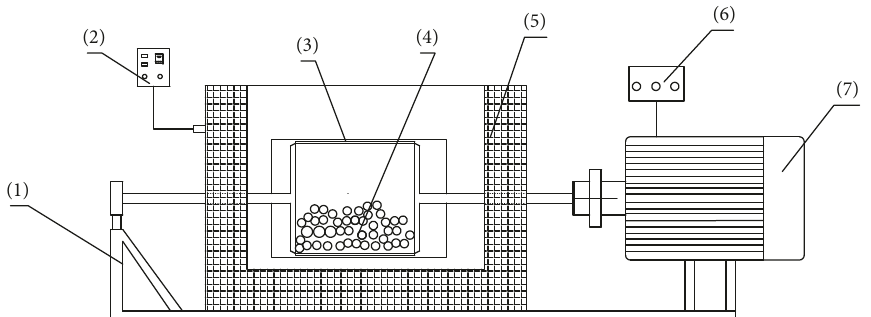
Figure 1: Illustration of the high-temperature ball mill. (1) Support base, (2) temperature controller, (3) ball-milling canister, (4) grinding ball, (5) furnace body, (6) speed regulator, and (7) electrical motor.